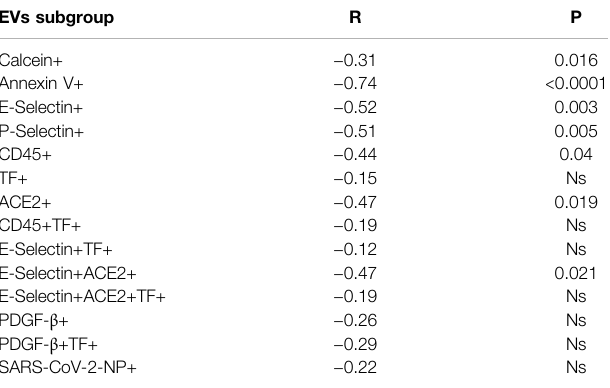
TABLE 5 | Correlations between EV levels and functional EV test (PPL).